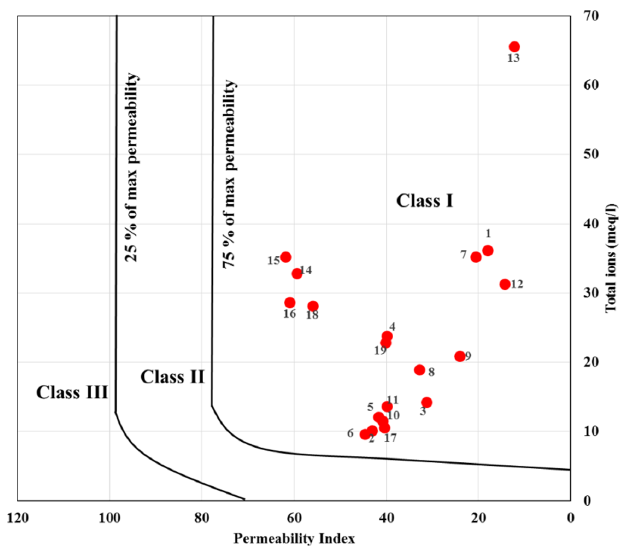
Figure 6. USSL Classi fi cation of irrigation water in study area, based on permeability index.